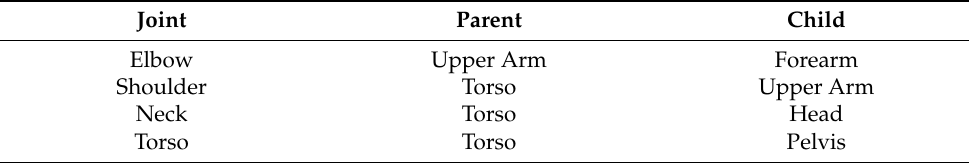
Table A1. Definitions of Parent and Child Segments for each joint of